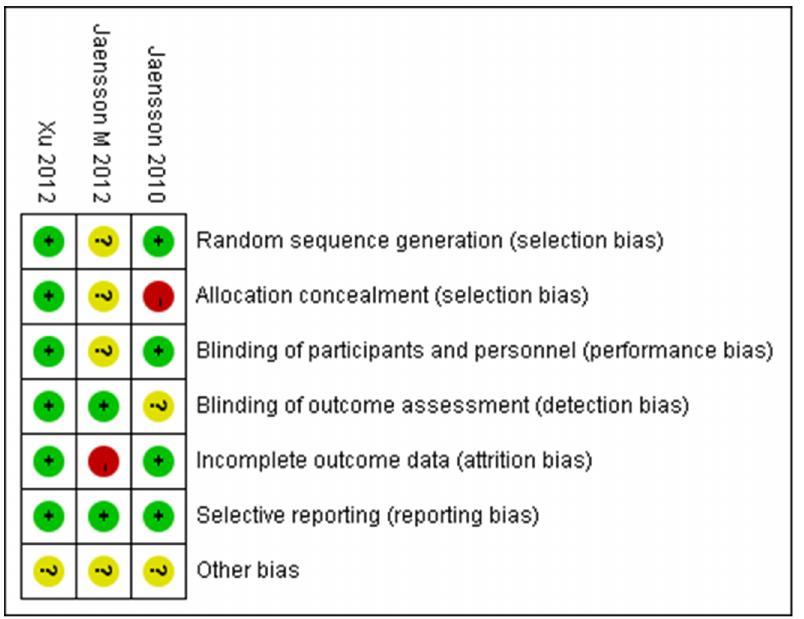
Figure 3. Risk of bias summary: review authors’ judgements about each risk of bias item for each included study.